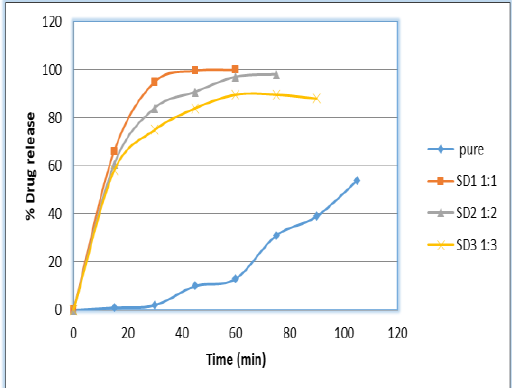
Figure (2). Effect of Drug: SA ratio of MLX- solid dispersion on the in-vitro dissolution profile of MLX in phosphate buffer pH 7.5 at